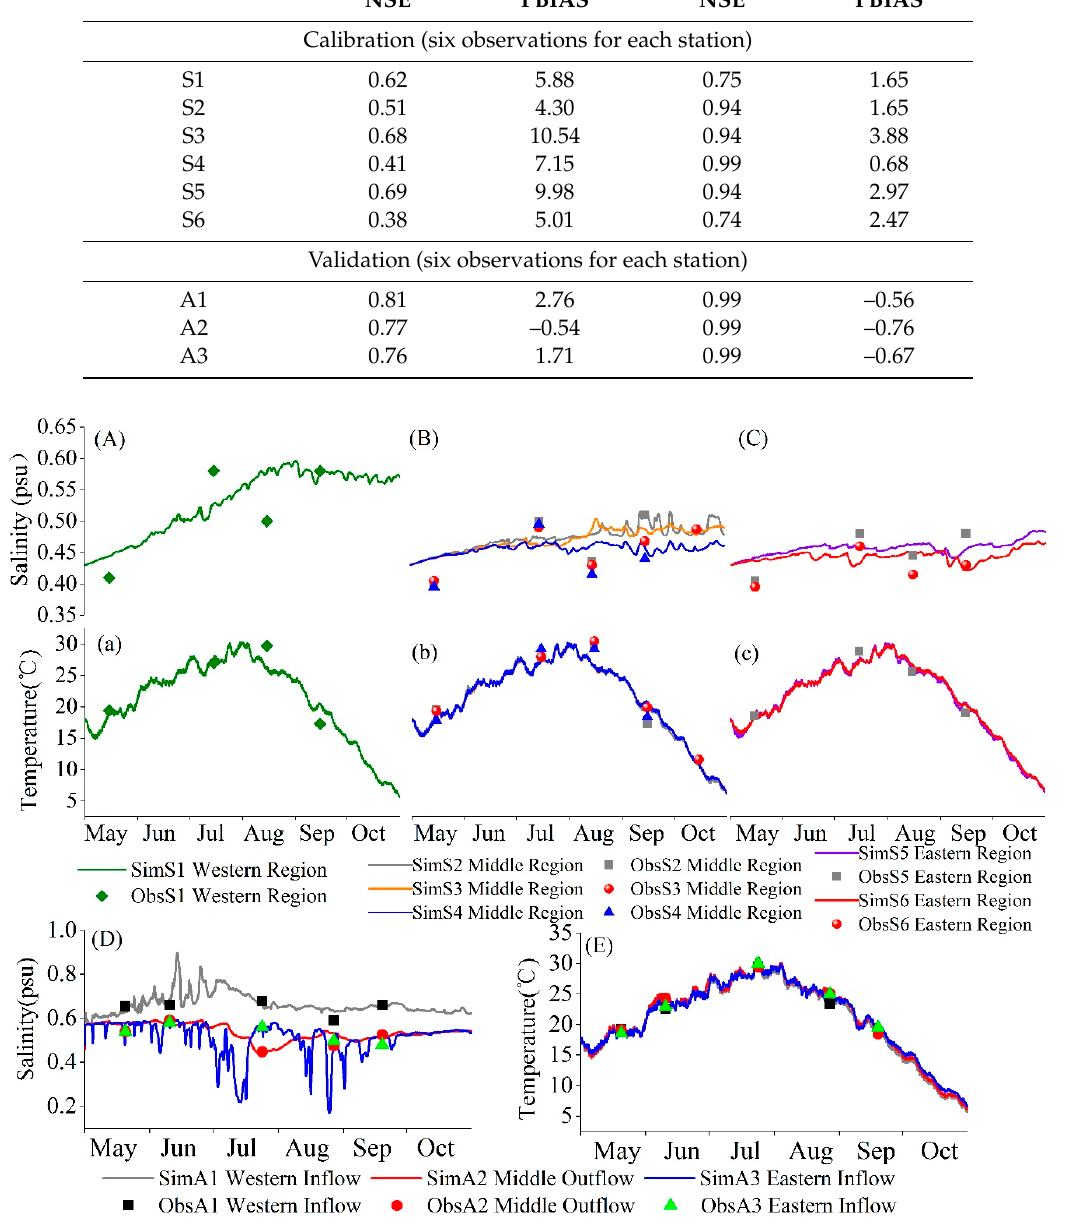
Figure 5. Comparison of observed and simulated salinity and temperature in different stations from May to October 2018. Stations S1–S6 were used for calibration and stations A1–A3 were used for validation (Sim and Obs refers to simulated and observed data, respectively).